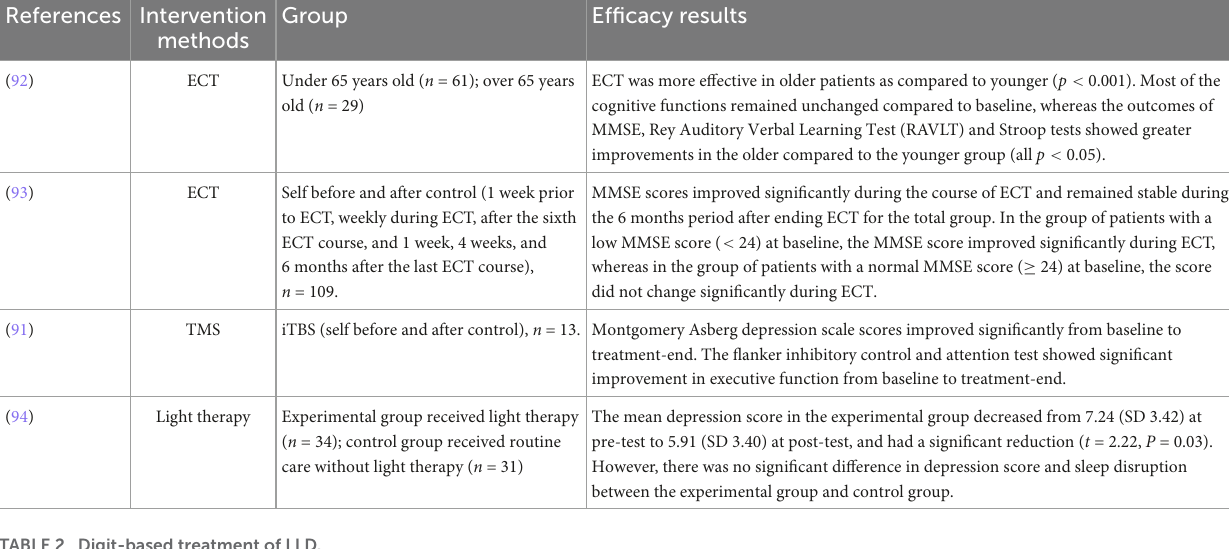
TABLE 1 The most common neuromodulation therapy of LLD.